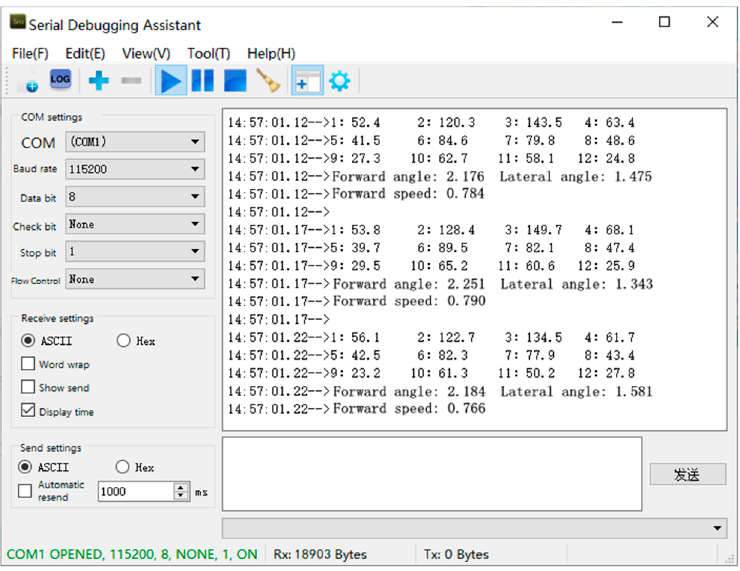
Figure 8. Wireless serial communication measurement